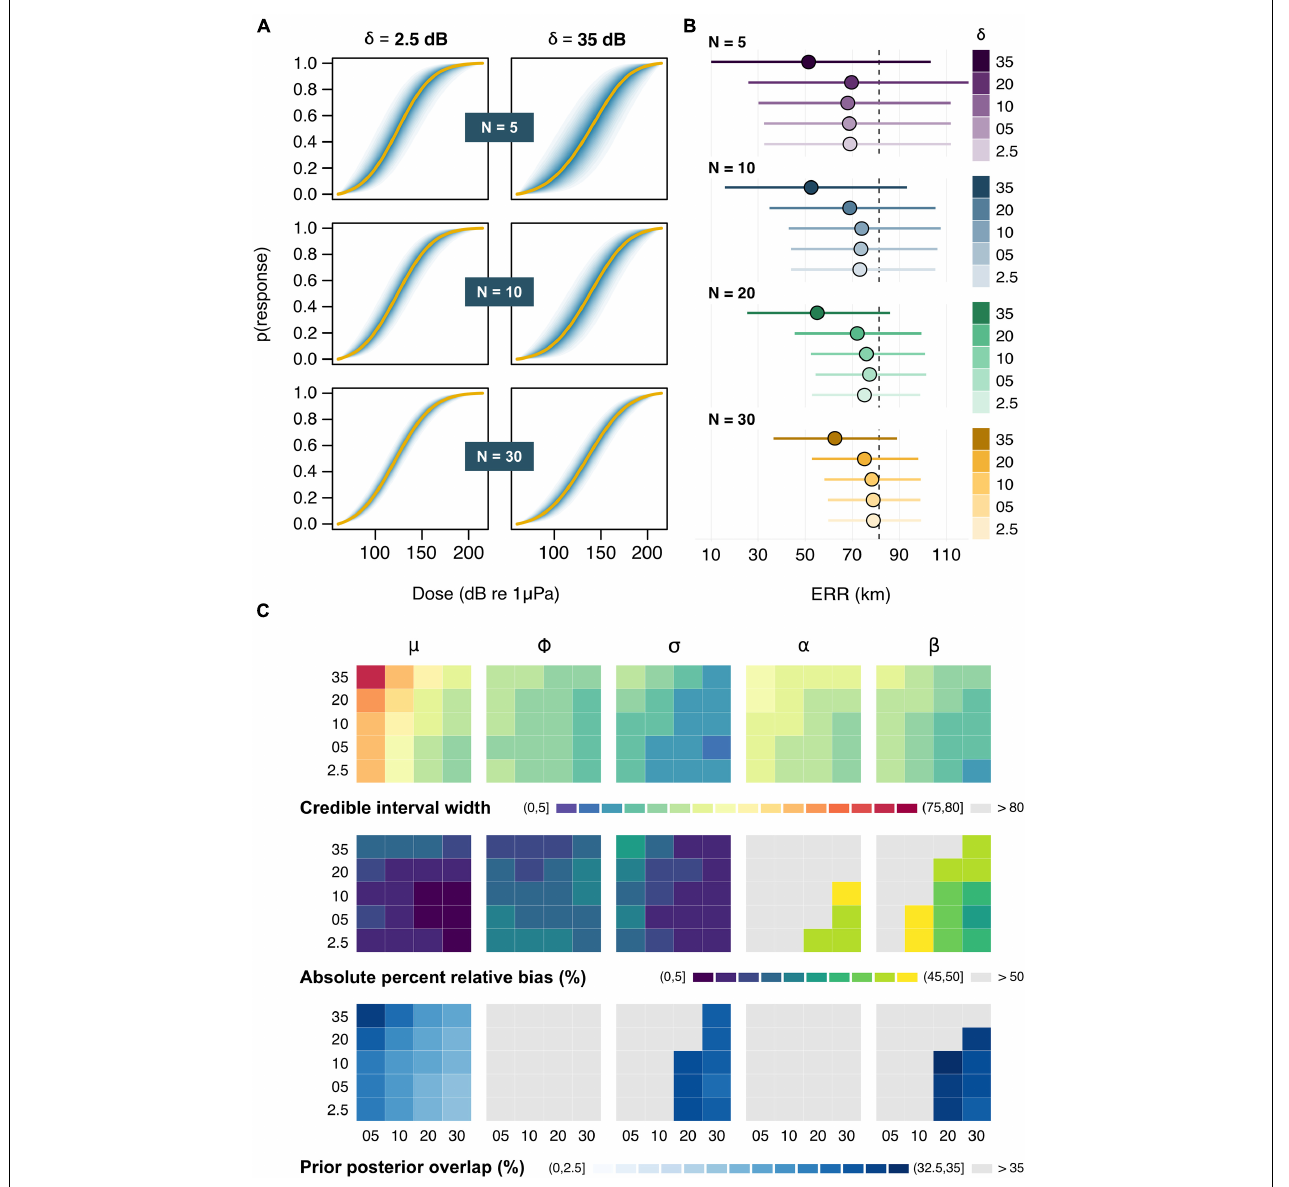
FIGURE 3 | Outputs from the reduced model. (A) Example dose-response curves for a subset of sample sizes (N) and sampling errors ( δ ). Solid lines represent the average posterior medians across Ns = 100 simulations, followed by the average 5, 10, 15 ... and 95% credible intervals in darker to lighter shades of blue. (B) Posterior estimates of the effective response range (ERR). Circles and bars respectively denote the average posterior median and credible intervals for each N × δ combination. The dashed line marks the true underlying value. (C) Summary of patterns in the precision, accuracy, and identifiability of posterior estimates across N (across) × δ (down) combinations. Results are shown (from left to right) for the location parameter relating to the mean response threshold for all whales ( µ ), the scale parameters relating to the between-whale variation ( phi ) and the within-whale between-exposure variation ( σ ), and the two contextual covariates ( α and β ). Rows indicate the average posterior credible interval width (in dB) [top], absolute percent relative bias (in %) [middle], and prior posterior overlap (PPO, in %) [bottom]. PPO values above 35% indicate that parameters may be non-identifiable